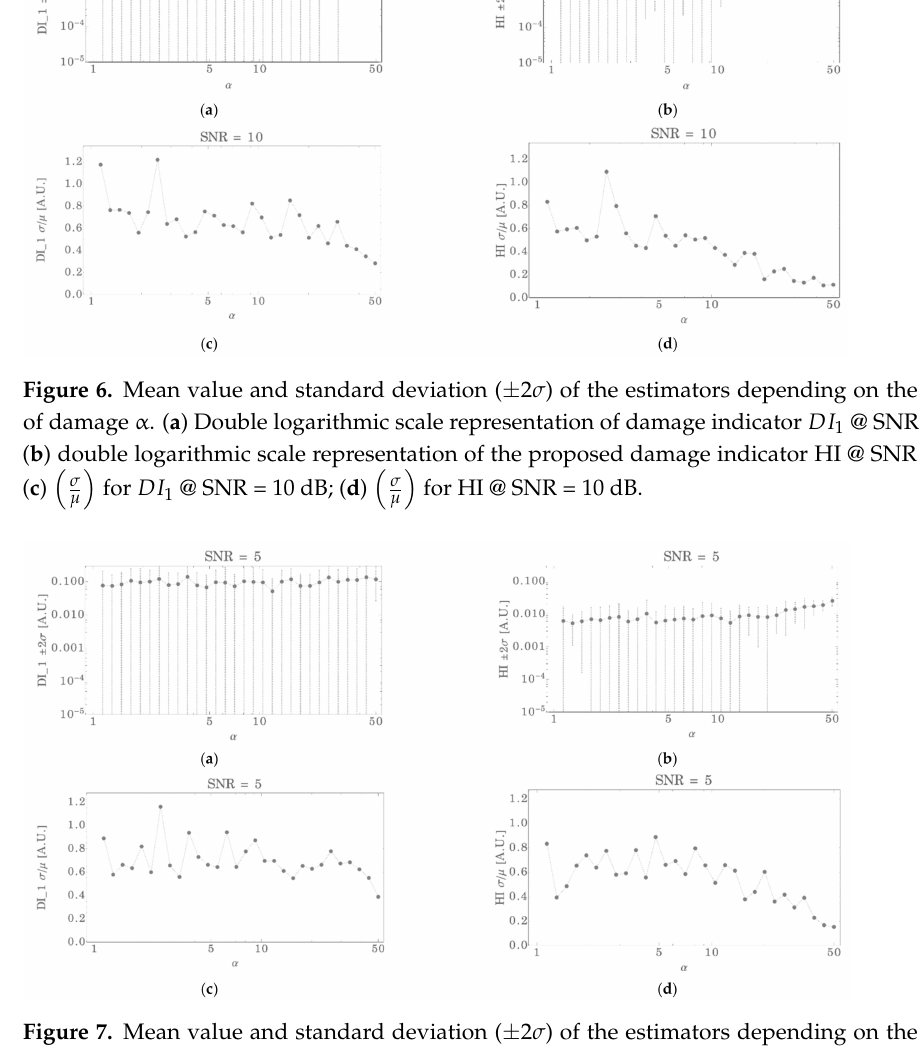
(cid:16) (cid:17) σ for HI @ SNR = 5 µ